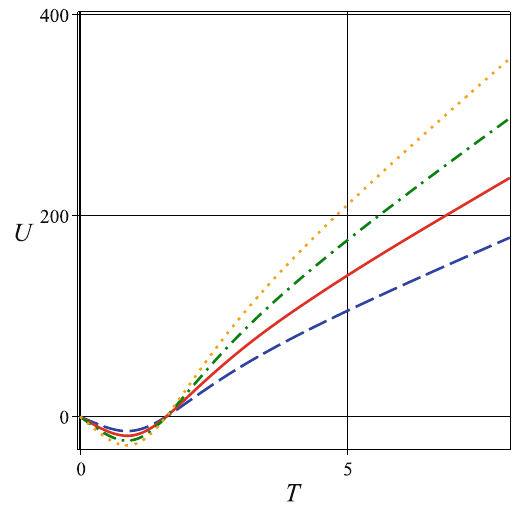
Fig. 4 Typical behavior of the internal energy in terms of T . N l = 5; l = 1 , 2 , 3 (blue dash), l = 1 , 2 , 3 , 4 (red solid), l = 1 , 2 , 3 , 4 , 5 (green dash dot); l = 1 , 2 , 3 , 4 , 5 , 6 (orange